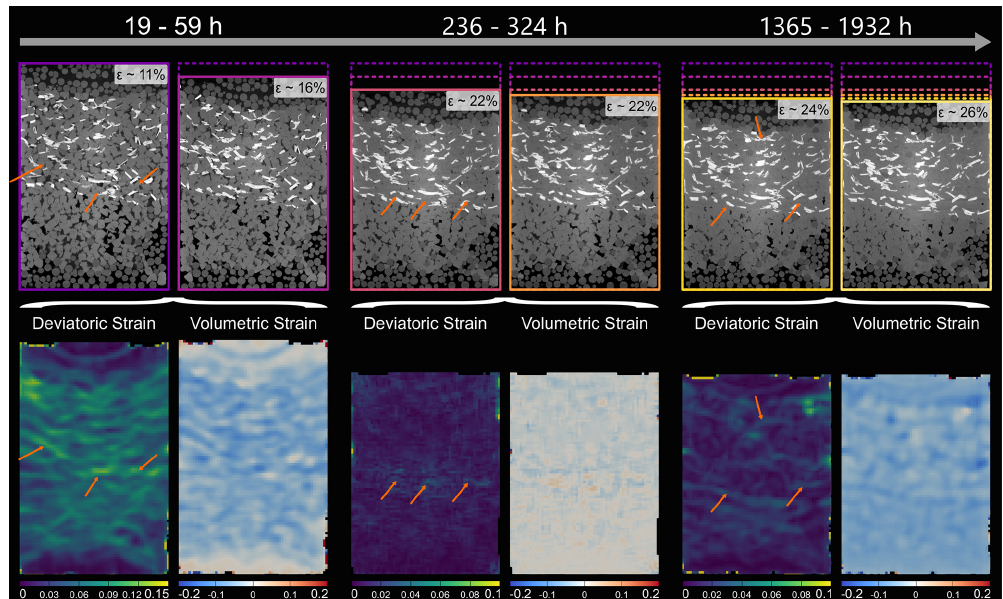
Figure 10. Locally resolved strain in the SB sample. The absolute values of deviatoric and volumetric strain were calculated from digital volume correlation for three different time steps. The top row shows the two microtomography scans which were compared to each other using digital volume correlation. Further, the contours are showing the sample dimensions, ranging in colour from purple for the least compacted sample to light yellow for the most compacted sample. In the bottom row, the results of the strain calculation are displayed. Note that the strains are cumulative and cover the entire time interval between the two selected scans. The time intervals increase from the left to the right and are 40, 88 and 567h. For the deviatoric strain, bright colours represent high strains, whereas dark colours represent low strains. For the volumetric strain, blue indicates compaction, while red indicates dilatation. Note the larger scale for the first time step of the deviatoric strain and that the strains are resolved on the grain scale. Arrows point to high deviatoric strains at NaCl–biotite interphase